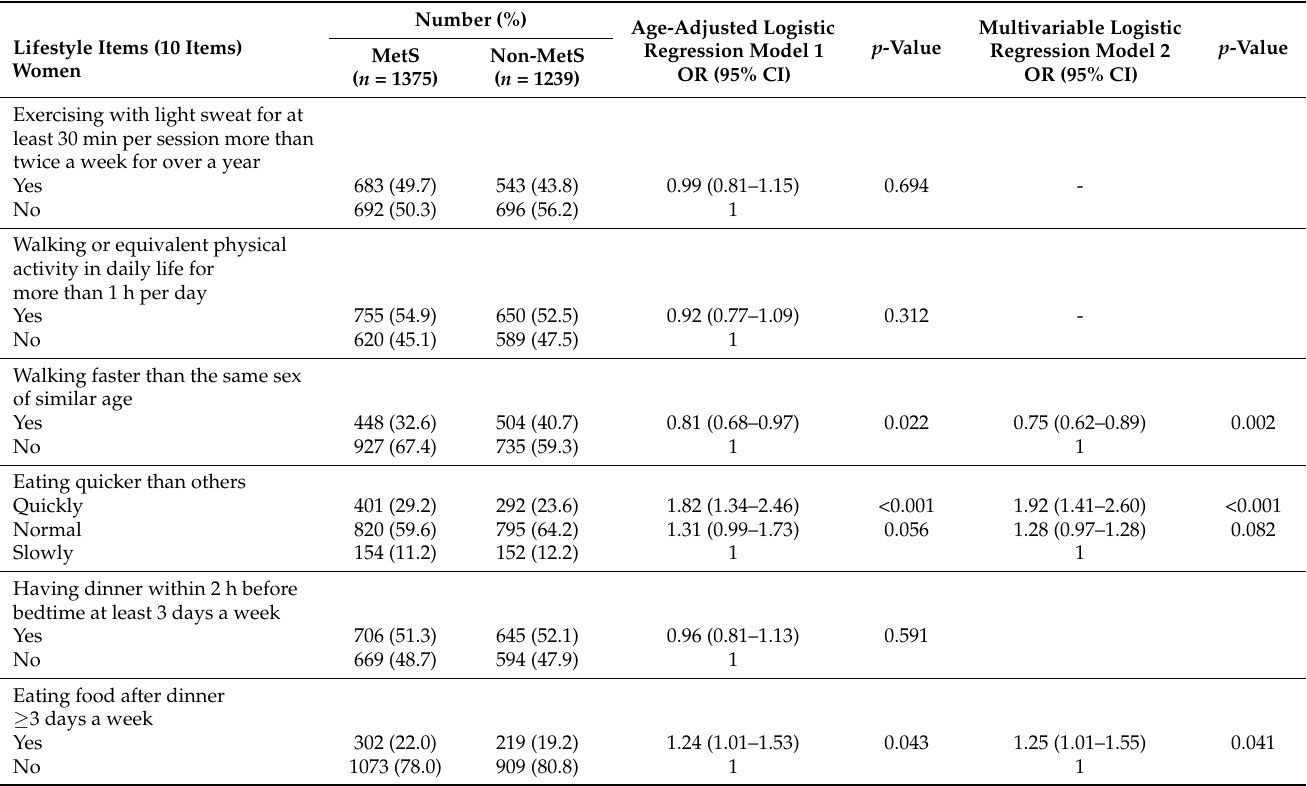
Table 4. Association between metabolic syndrome and lifestyle